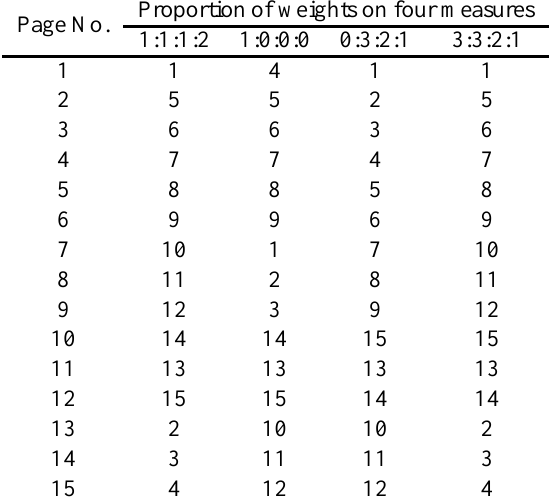
Table 1. Page sequence after scoring by WebScore under dis- tinct proportions of weights on these four measures. Page